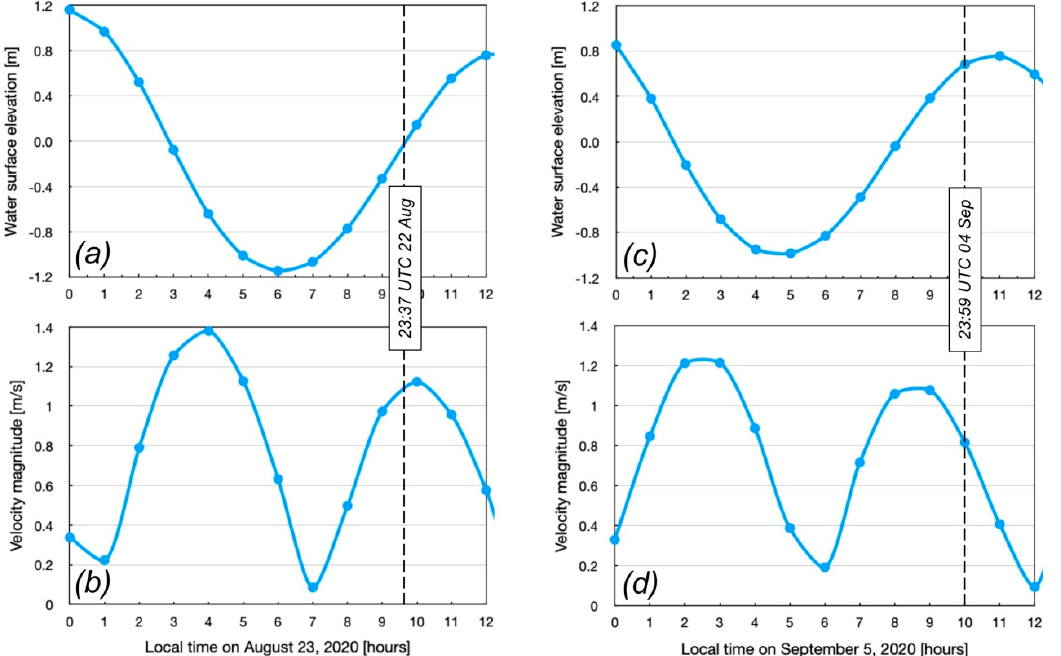
Figure 3. Predictions of water surface elevation and surface current speed coinciding with WorldView-2 data collected at 23:37 UTC 22 August 2020 ( a , b ) and 23:59 UTC 4 September 2020 ( c , d ), as indicated by the two dashed, vertical lines. Data shown were extracted from the “ereefs” model archive at the center of the study area shown in Figure 2.